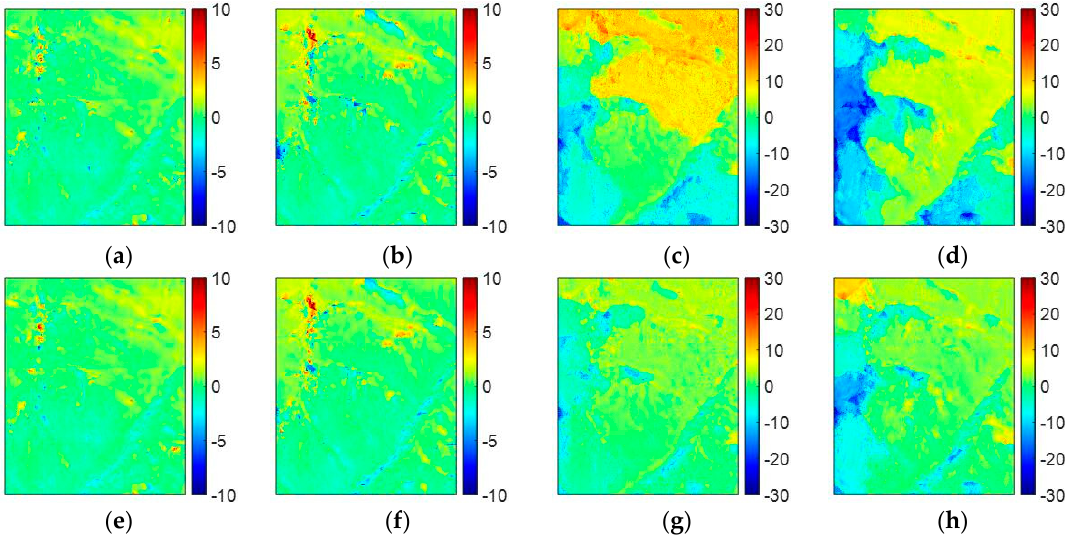
Figure 8. ( a – d ) PUMA errors of Figure 7j–m. ( e – h ) MB TSPA-PUMA errors of Figure 7n–q. Table 7. Statistical information of PU performance in Figure 8a–h.